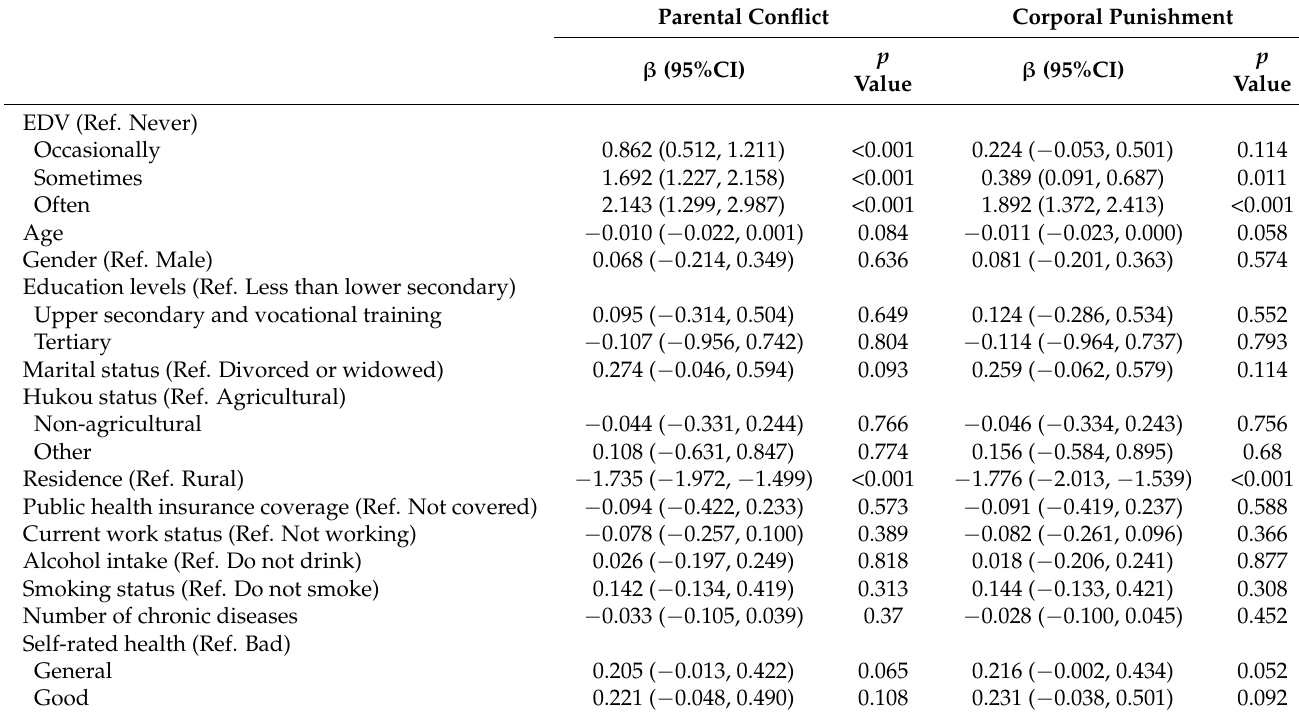
Table 3. Association between EDV and depressive symptoms based on random-effects linear